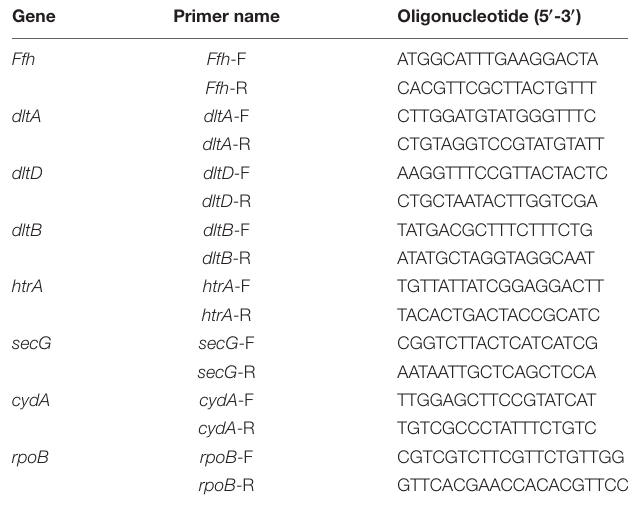
TABLE 1 | Oligonucleotide primers used for qRT-PCR